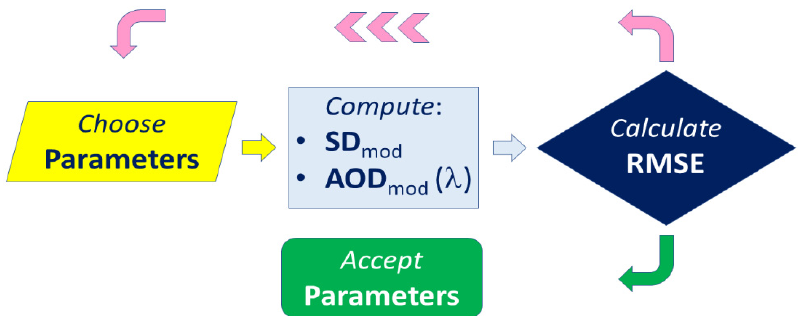
Figure 1. Flowchart of the AOD fitting showing the three main steps regarding (1) choice of a set of parameters ( C v and r v ) for describing both fine and coarse modes of the model SD, (2) computation of the model SD (symbol “mod”) and the corresponding spectrally resolved AOD using the chosen parameters, and (3) calculation of the root mean square error (RMSE) between the model and measured spectrally resolved AODs. The AOD fitting works by repeatedly choosing a new set of parameters, and then rejecting (magenta arrows) or accepting (green arrow) it with the RMSE threshold.